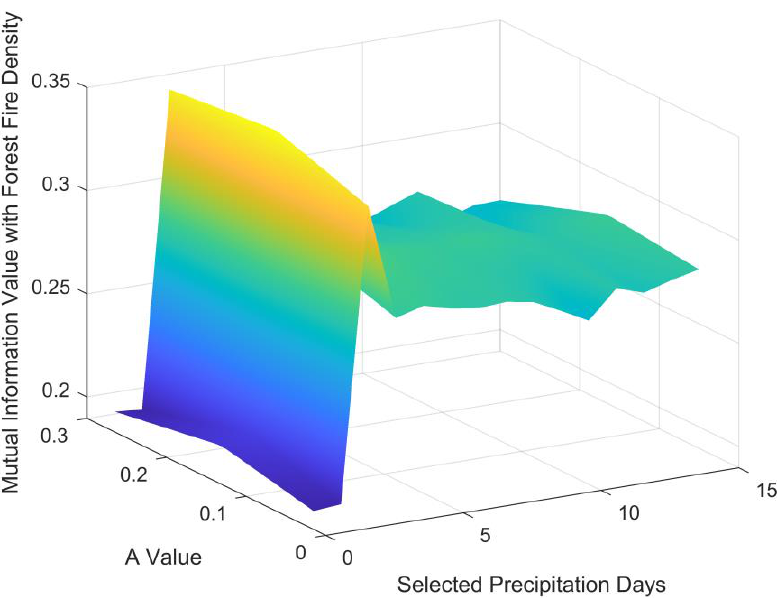
Figure 1. Mutual information value between different comprehensive precipitation index and forest fire density.